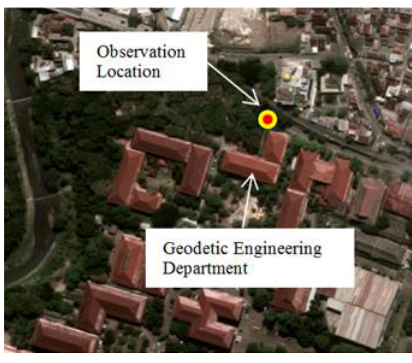
Fig. 9. Location of the obstructed experiment